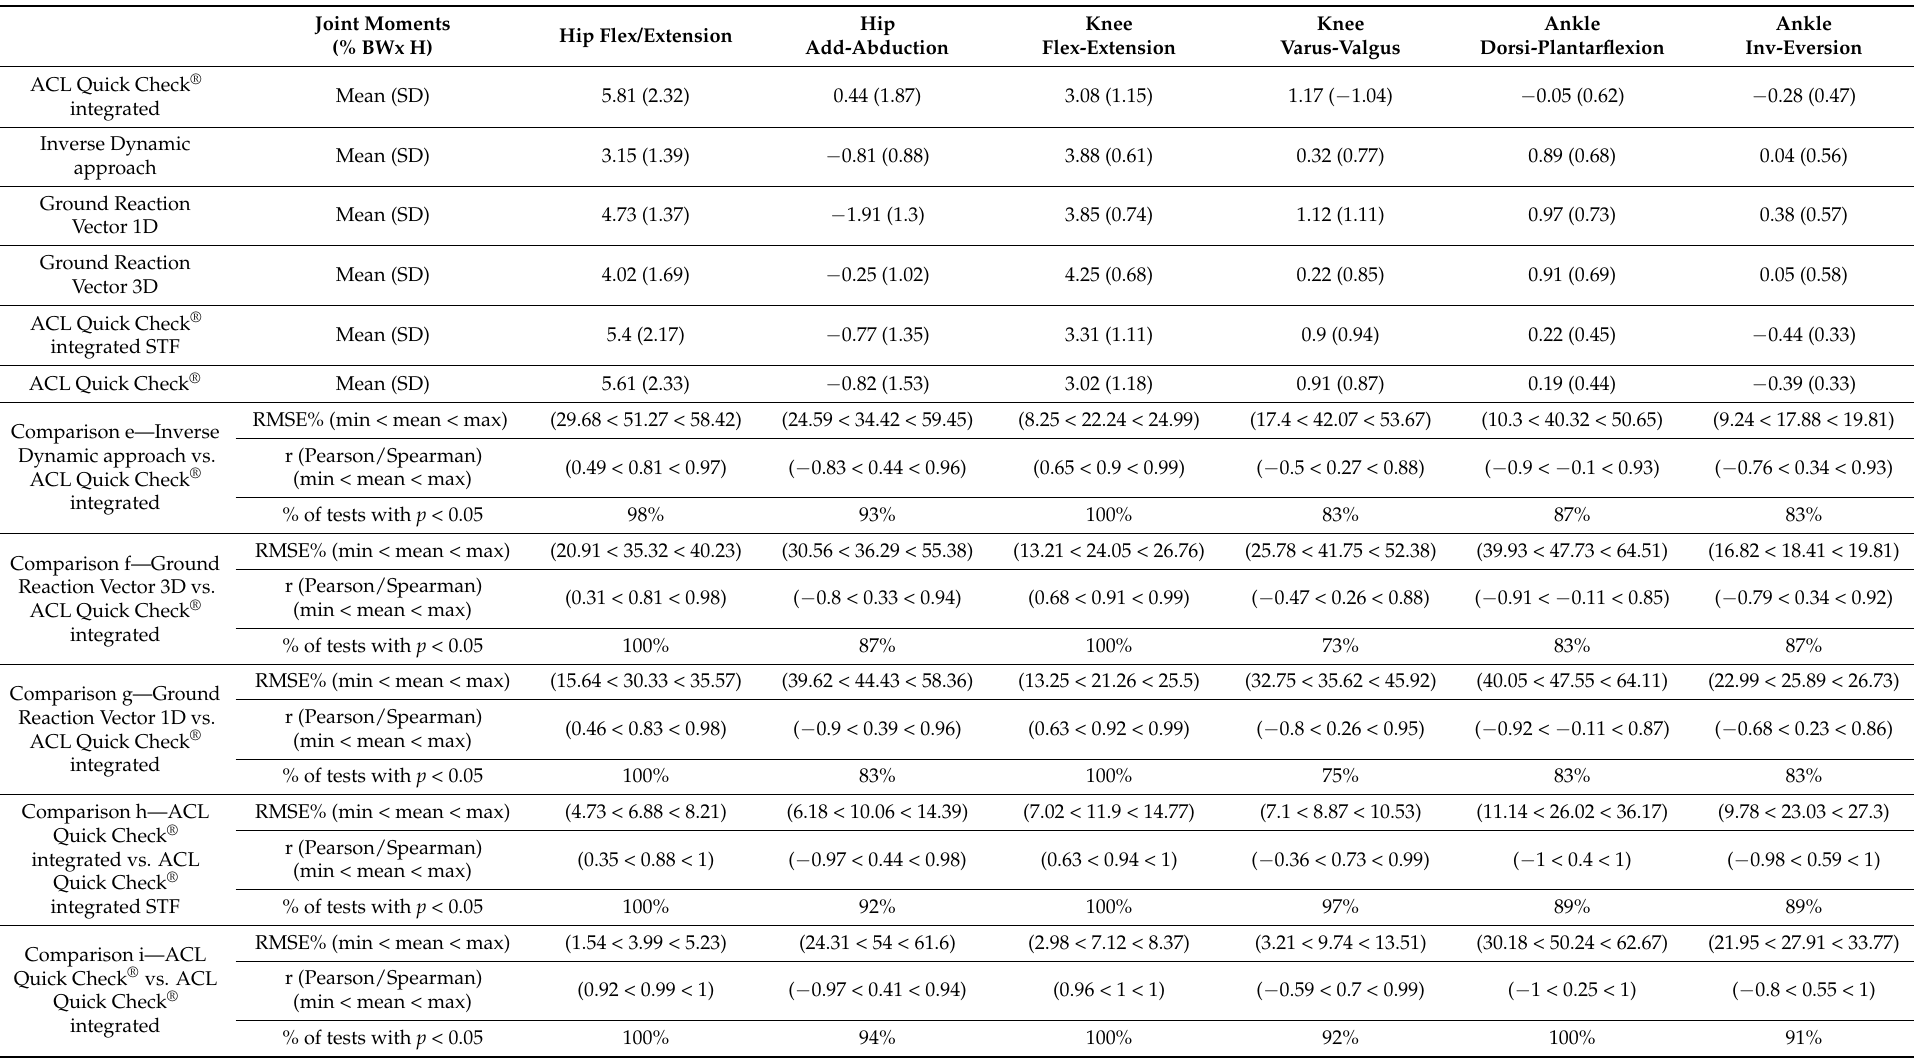
Table 5. Results of the comparisons between the different methods for the calculation of joint moments (points from e to i in the method